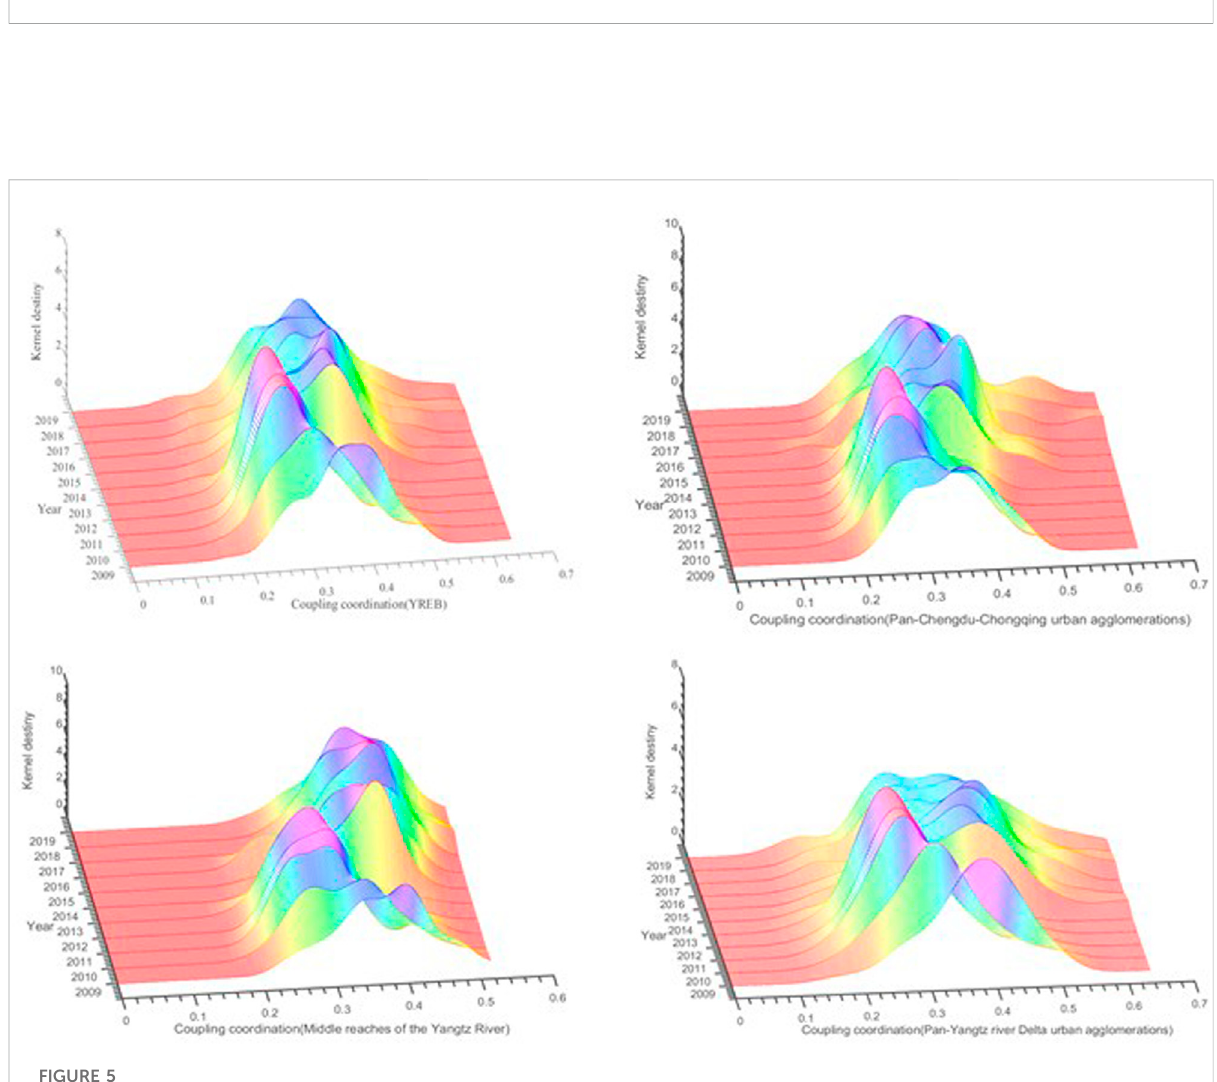
FIGURE 5 Kernel density estimation of coupling degree between the USFD and green economic development in the YREB and three urban agglomerations.